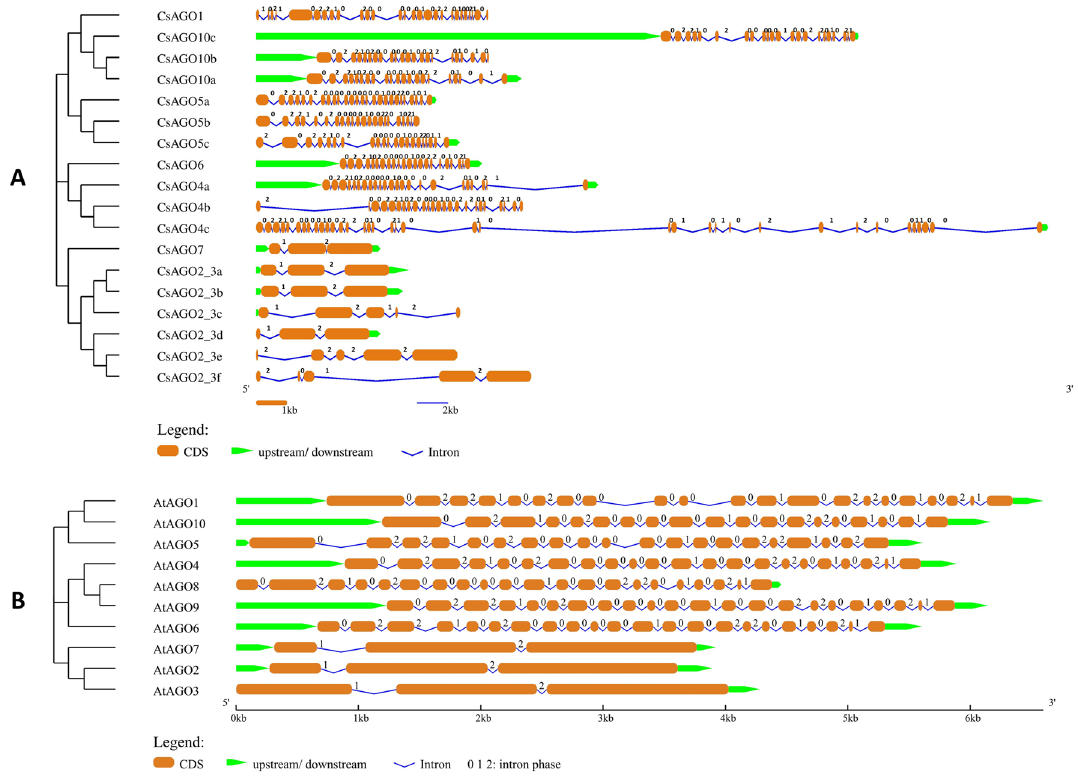
Figure 2. Gene structures showing the organization of exons and introns, and associated intron phases [0, 1 and 2] of ( A ) CsAGO and ( B ) AtAGO genes. The NJ phylogenetic tree of CDS is shown on the left side of the figure.